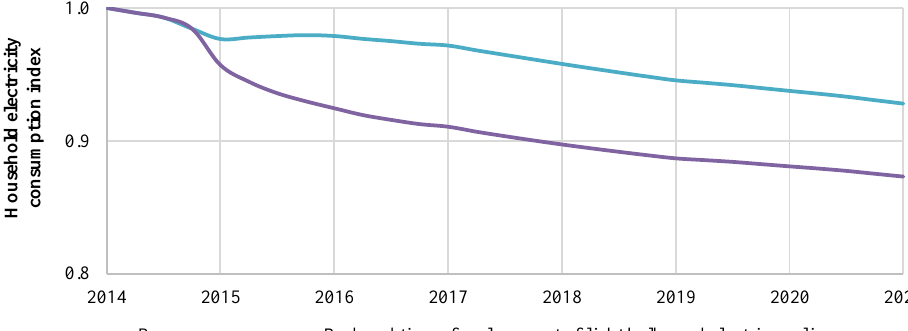
Base case Reduced time of replacement of light bulbs and electric Fig. 9. Total household electricity consumption index – base case (the reference mode) and the case with time of replacement of light bulbs and electric appliances being nearly 0 (the initial consumption: 1887 GWh/year). Additional tests, i.e. consistency of units, change of time step, tests with extreme values were carried out to gain confidence in the model. Outputs of the model, as partly demonstrated in the “Results and Discussion” section, e.g. with relation between electricity-cost income ratio and motivation to replace light bulbs (Fig. 10 and Fig. 11), seem to change in a “logical way” in response to inputs and therefore it was concluded that the model can be used for the intended assessment.